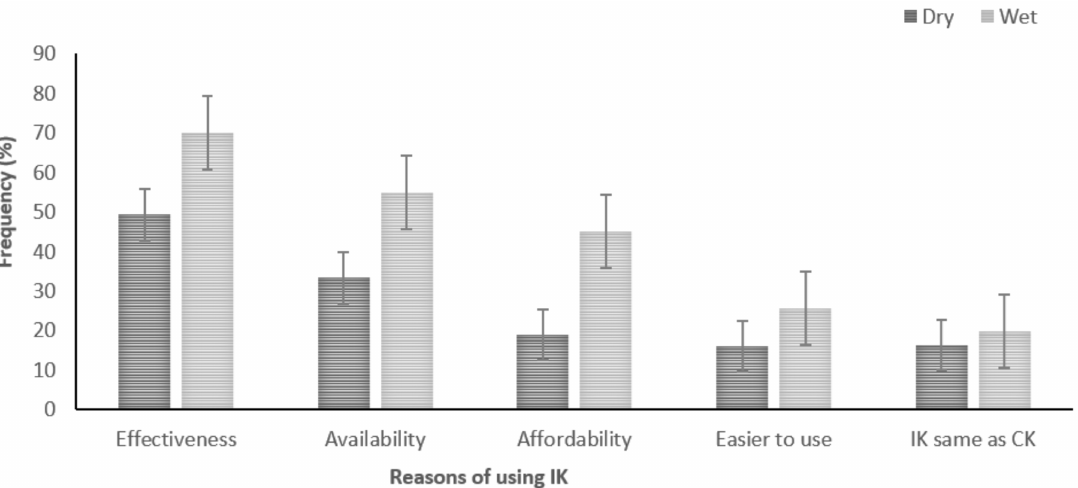
Figure 2. Reasons for using indigenous knowledge to control nematodes in goat. IK: Indigenous knowledge, CK: Conven- tional knowledge. Effectiveness: works as well as CK; Availability: easily accessible; Affordability: lower cost; Easier to use, does not require a manual for instructions.